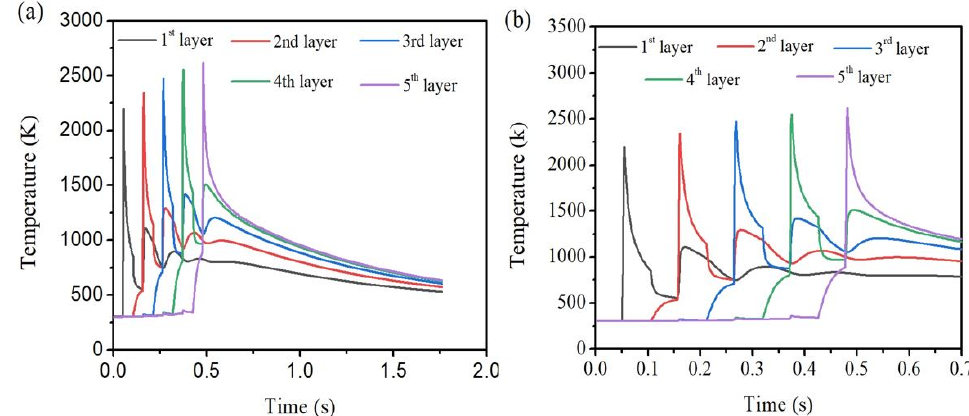
Figure 6. Time-temperature history ( a ) full view, ( b ) zoomed view considering only up to 0.7 s of scanning time, at the centre of each layer for dataset#6.